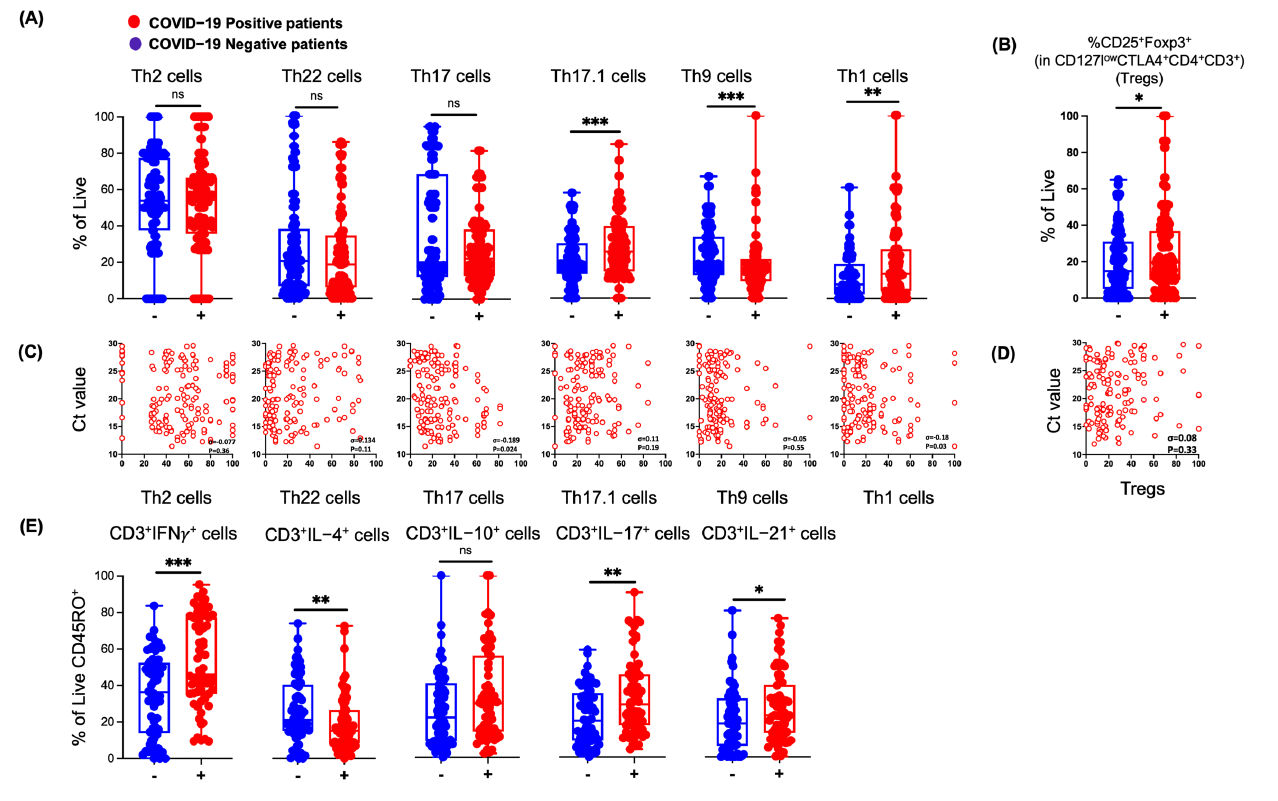
Figure 4. SARS-CoV-2 infection in humans results in broad changes in the nasopha- ryngeal T lymphocyte subsets. ( A ) RT-PCR COVID-19-positive patients showed higher Th1 and Th17.1